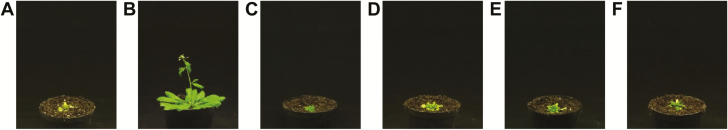
Complementation of the A. thaliana hma2hma4 zinc deficiency phenotype. D688A (C), P366L (D), E169A (E), and K667A (F) HMA4 variants fused to GFP were expressed in hma2hma4 plants under the control of the pAhHMA4-2 promoter. The plant phenotypes are shown after 5 weeks of growth on soil without zinc supplementation. hma2hma4 plants not transformed (A) or expressing the native HMA4 fused to GFP (B) were used as negative and positive controls, respectively. Pictures are representative of the observations of at least 12 independent lines/plants from two independent experiments for each genotype.